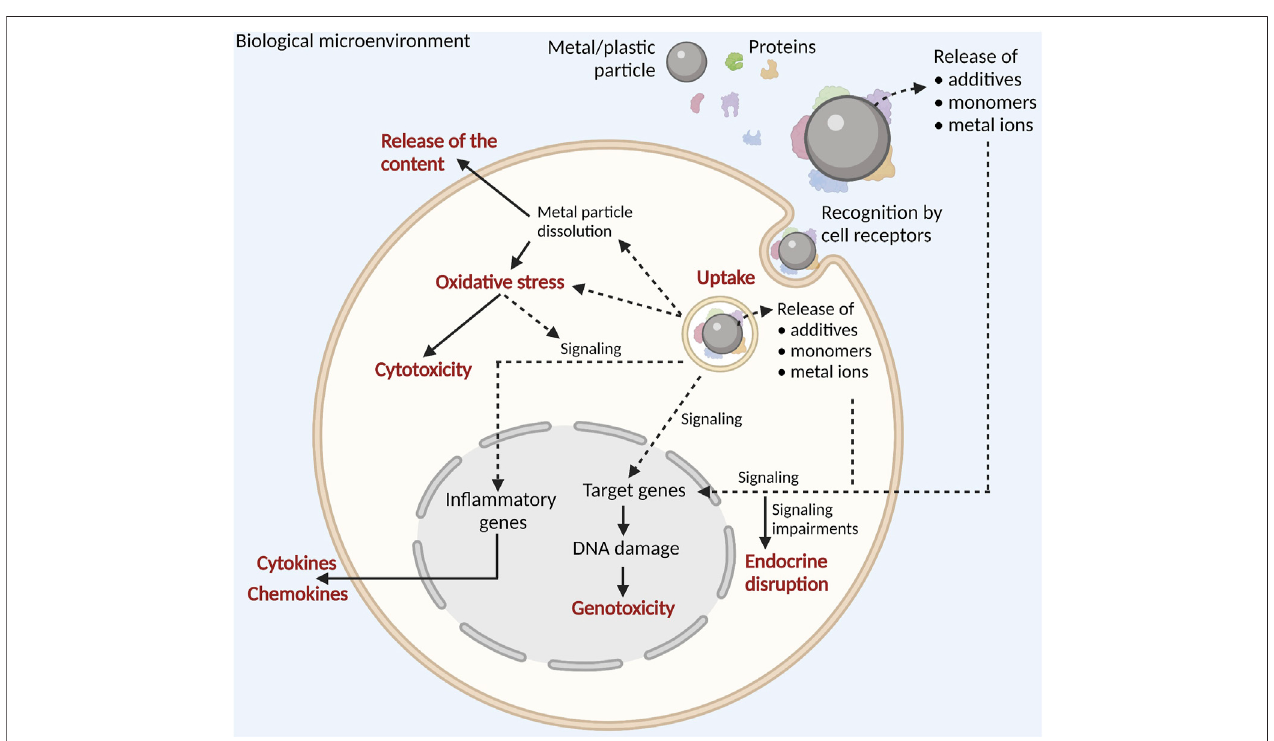
FIGURE6| Particle-inducedeffectsinthehumancells.Bothintheextracellularandintracellularmilieu,particlespotentiallyreleaseadditives,monomers,ormetallic ions (depending on the particle chemical composition). After recognition and internalization, particles affect cell physiology in numerous ways by involving extensive signalingleadingtochangesintheexpressionoftargetgenes,resultinginin fl ammation,endocrinedisruption,genotoxicity,orcytotoxicity.Moreover,metalionsreleased during dissolution of metal particles may induce oxidative stress that may trigger in fl ammation and/or cytotoxicity.